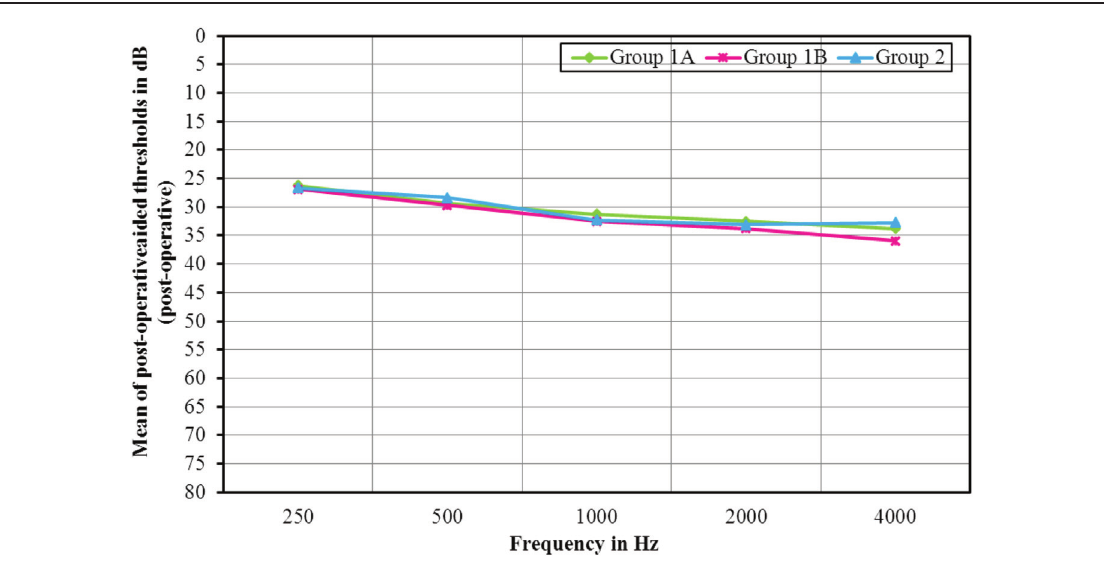
Aided hearing thresholds for the three studied groups.